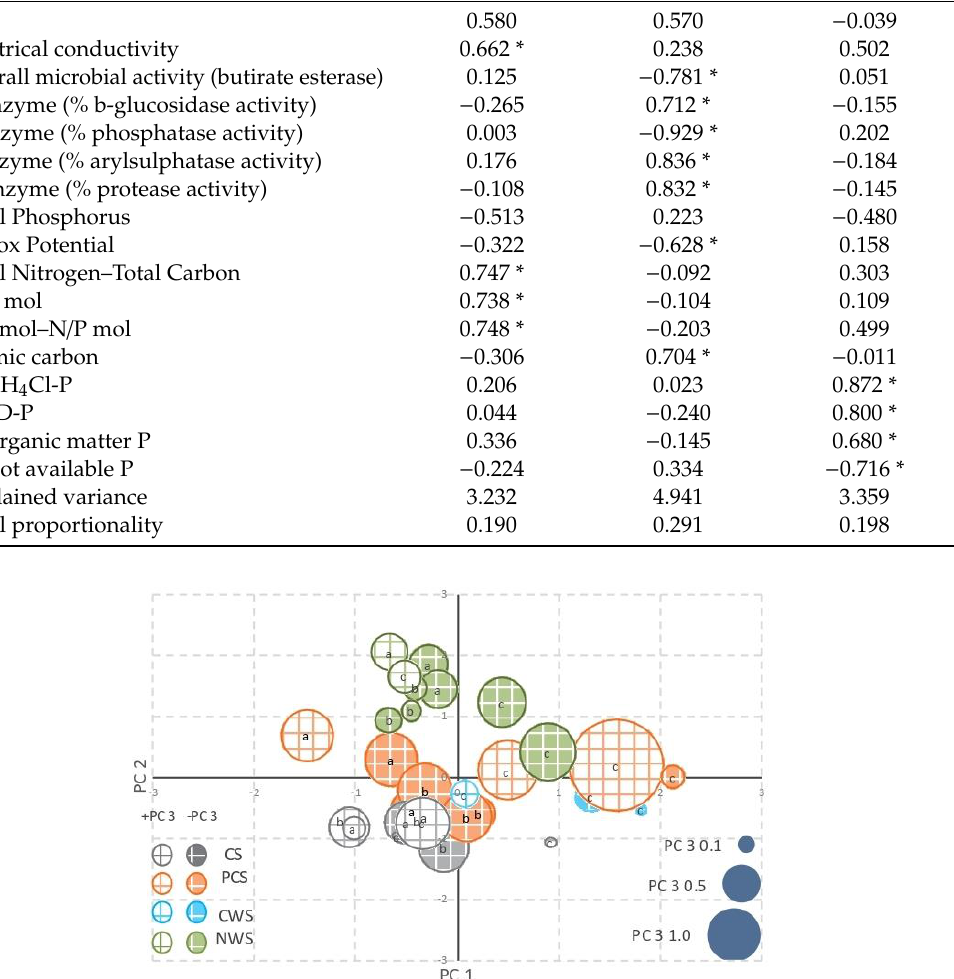
Figure 4. Principal component analysis. Bubble-plot of scores: PC1 ( x -axis) vs. PC2 ( y -axis) vs. PC3 (area of each bubble). CS, in grey color; PCS, in orange color; CWS, in light blue color; NWS, in green color. PC3 positive values, white background with colorful square lines; PC3 negative values, colored background with white square lines. Label a: 0 – 20 cm layer; label b: 20 – 40 cm layer; label c: 40 – 60 cm layer.